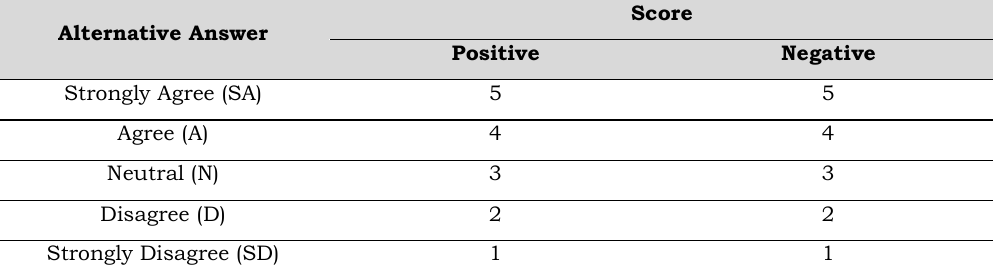
Table 2. Measuring using Likert